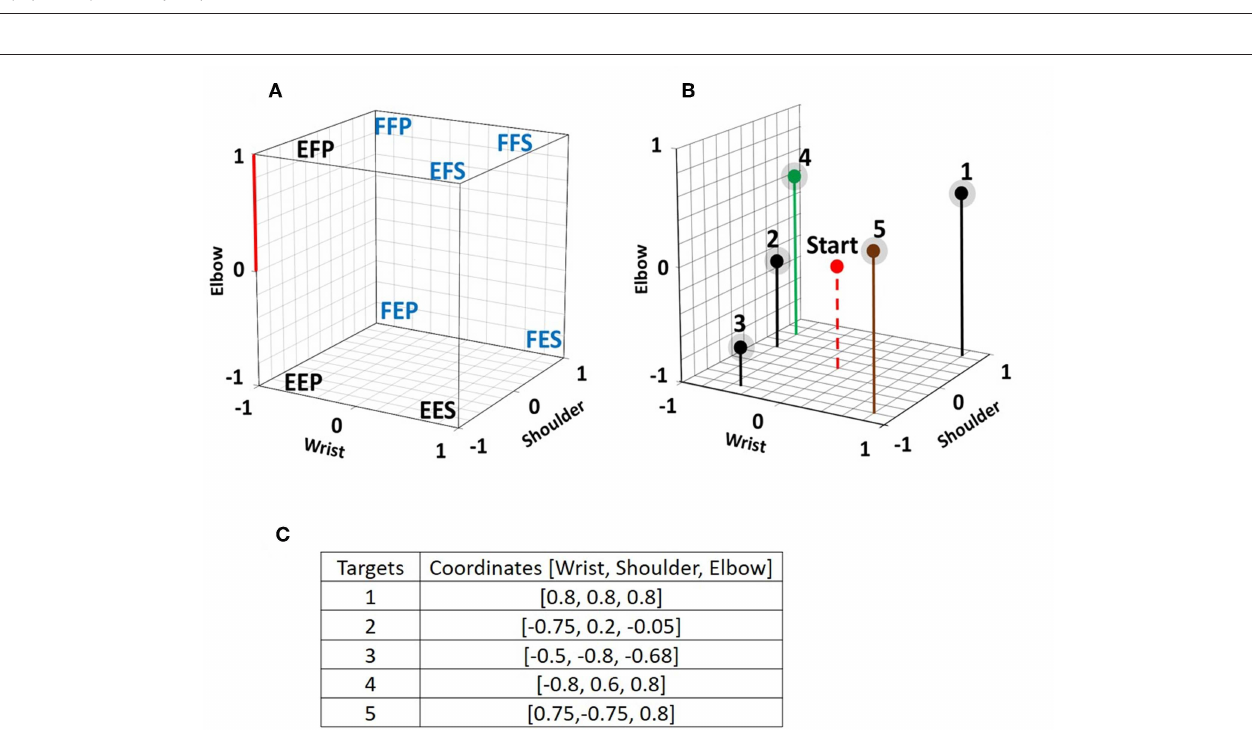
FIGURE 2 | (A) Each of the eight chosen static postures is assigned to a corner of a virtual cube displayed on a computer screen. Each axis of the cube represents the normalized angular changes at the shoulder, the elbow, and the wrist joint. Experiments were done with the eight illustrated postures and with a subset of five postures which are identified with a blue font. On the Elbow axis, the distance between 0 and 1 is used as the reference length to which distance, length and diameter measures are compared. (B) 3D view of the 5 targets within the cube. In each trial, the initial position of the red sphere is in the center of the cube and subjects have to move it so that it reaches one of the targets, which have a diameter of 0.2 including their grayed surrounding. The red sphere is only a point in the program, but it is displayed with a given diameter to make it visible to the subjects. (C) 3D coordinates of the five targets.